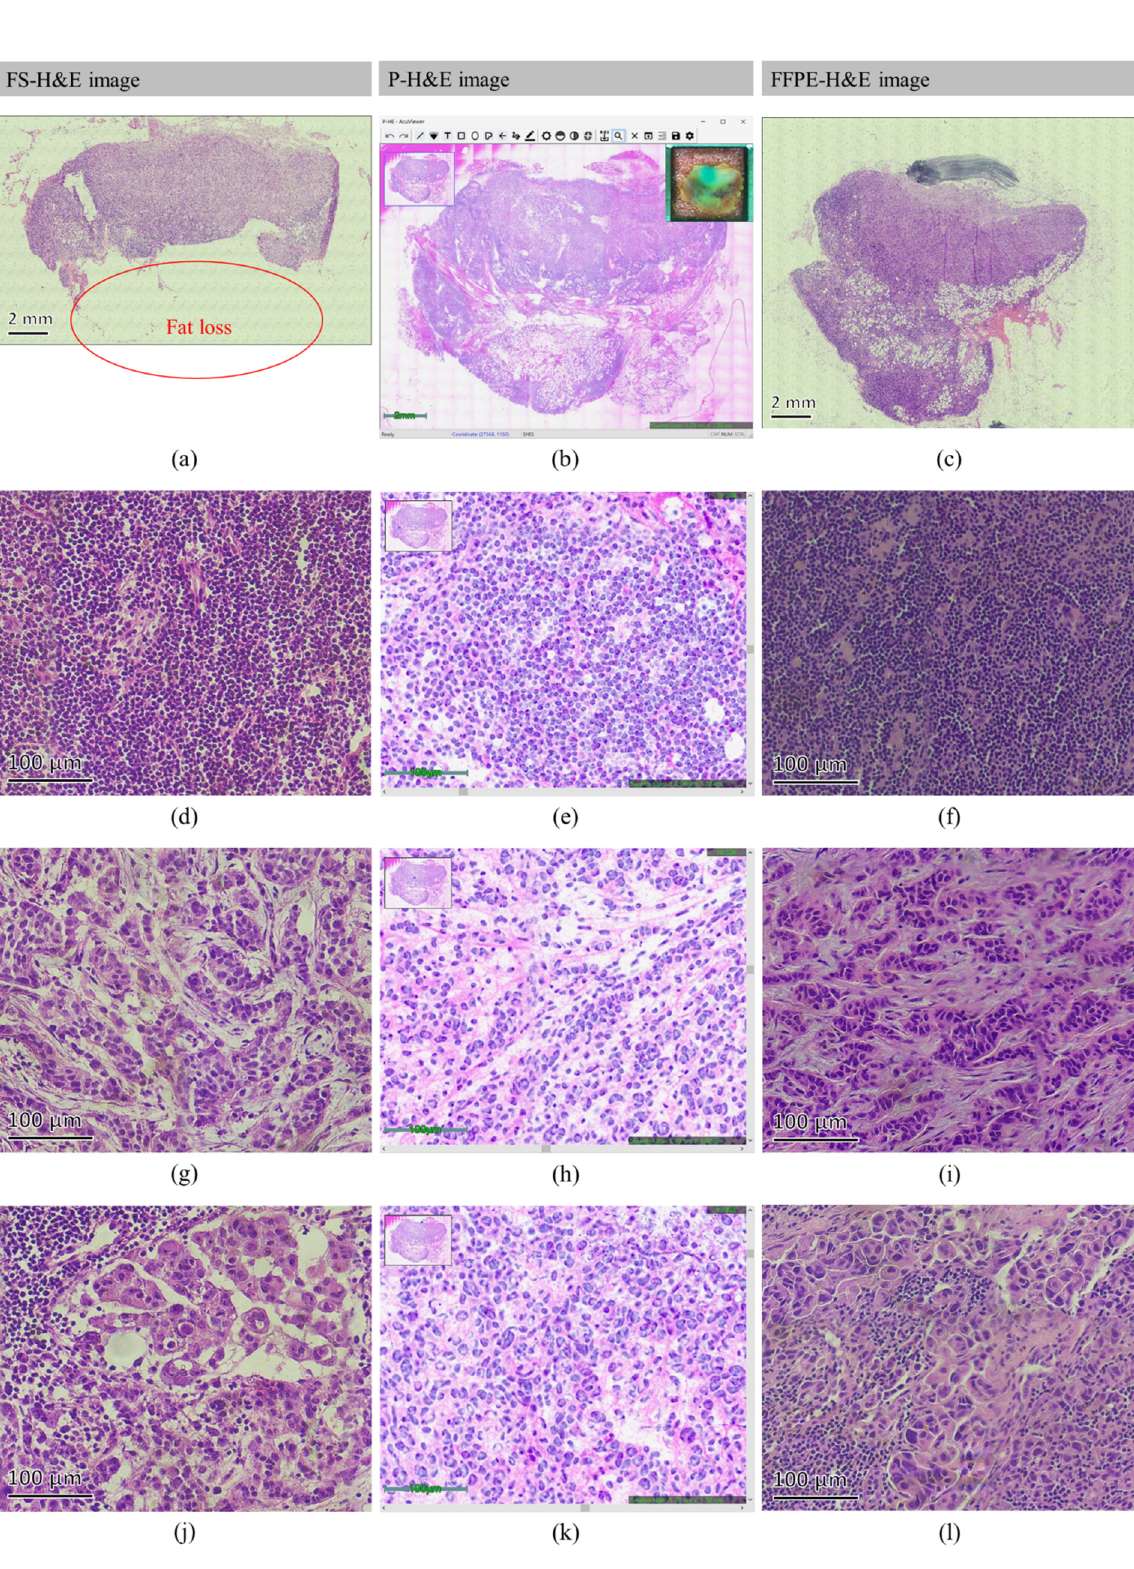
Figure 5. Comparison of FS-H&E, p-H&E, and FFPE-H&E images acquired from the same IDC-metastatic SLN #A1 of patient #28. ( a – c ) present the images of the true-tissue snapshot (top-right inset) of ( b ); the top-left inset of ( b ) is the browsing navigator. In ( d – f ), lymphocytes are crowdedly distributed in all figures. ( g – i ) display the poorly formed glandular morphology of cancerous aggregation. ( j – l ) show disordered growths with poor differentiation in morphology.